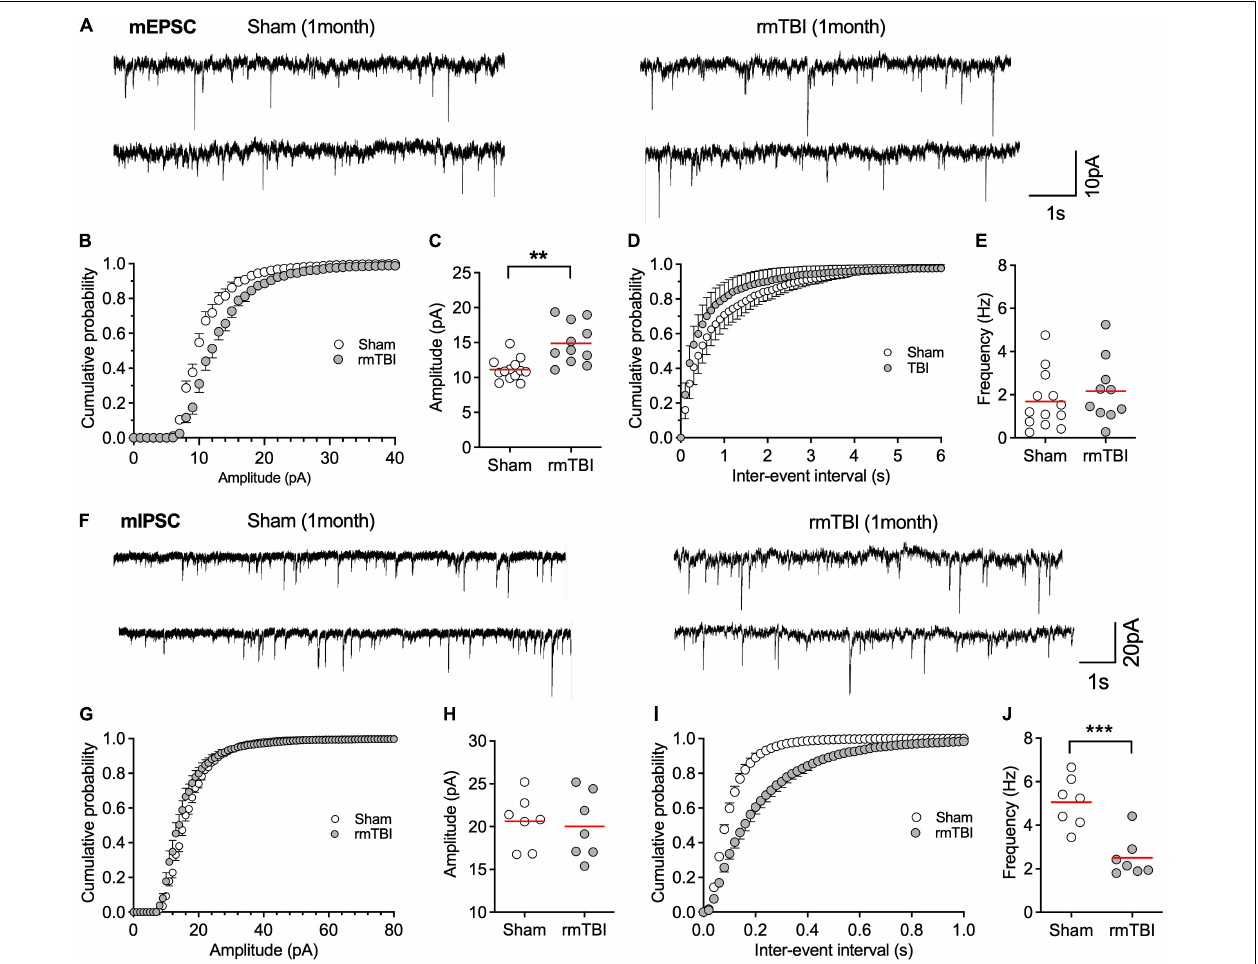
FIGURE 9 | rmTBI on synaptic transmission in mPFC. (A) Representative traces of mEPSC from rats 1 month after rmTBI and time-matched control rats with sham injury. (B) Cumulative probability and (C) average amplitude of mEPSC. (D) Cumulative probability and (E) average frequency of mEPSC. (F) Representative traces of mIPSC from rats 1 month after mTBI and time-matched control rats with sham injury. (G) Cumulative probability and (H) average amplitude of mIPSC. (I) Cumulative probability and (J) average frequency of mIPSC. Each dot represents data from one neuron. Recordings were from 6 rats with sham TBI and 6 rats rmTBI. ** P < 0.01, *** P < 0.001 by t